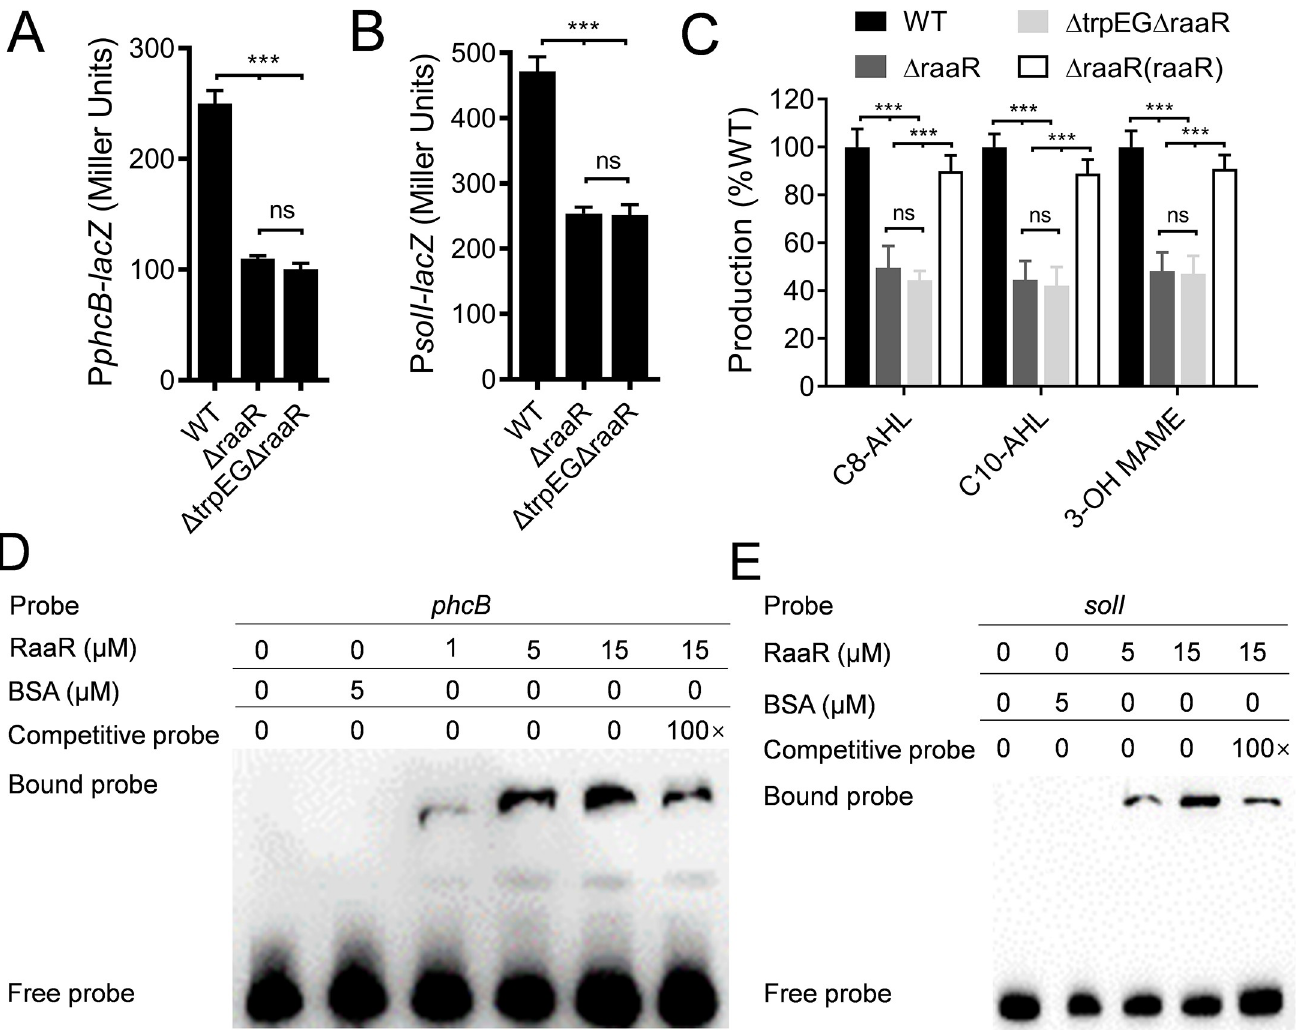
Fig 3. Influence of raaR on the QS signal production of R . solanacearum . Effects of raaR on the gene expression levels of phcB (A) and solI (B) and on QS signal production (C) in R . solanacearum GMI1000. We used promoter activity assays to quantify gene expression. The data are the means ± standard deviations of three independent experiments. ��� p < 0.001 (unpaired t-test). EMSA analysis of the in vitro binding of RaaR to the promoters of phcB (D) and solI (E); biotin-labeled 327-bp phcB and 324-bp solI promoter DNA probes were used for the protein binding assay. A protein-DNA complex, represented by a band shift, was formed when different concentrations of RaaR protein were incubated with the probe at room temperature for 30